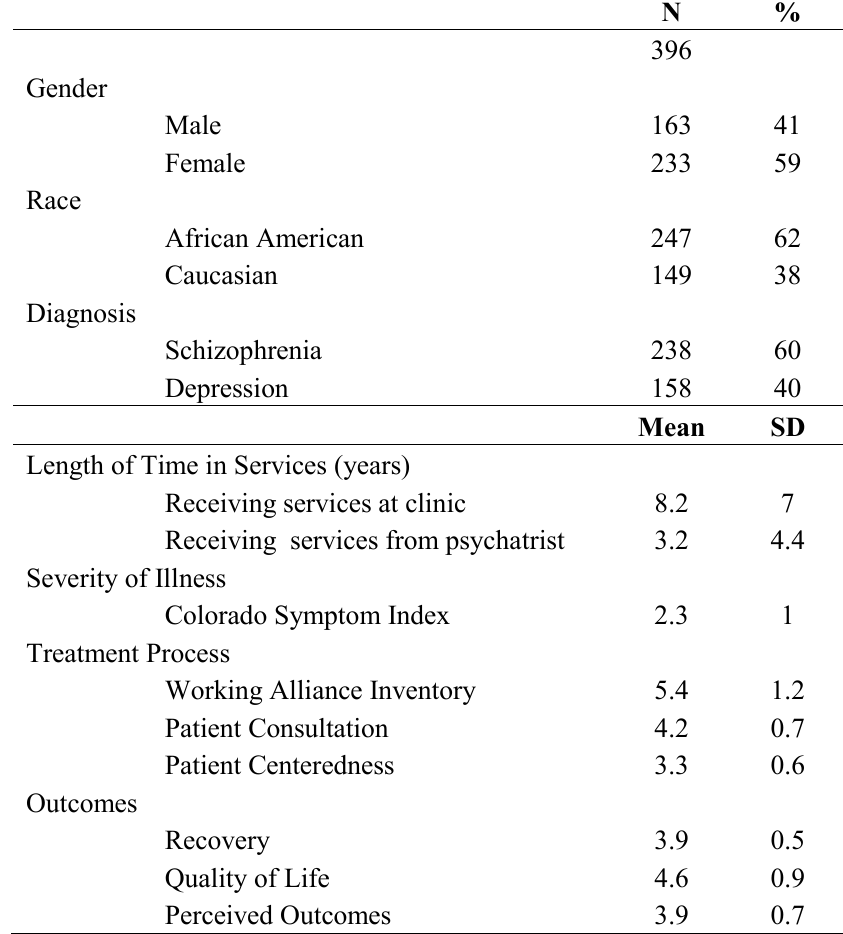
Table 1. Demographics, treatment process and